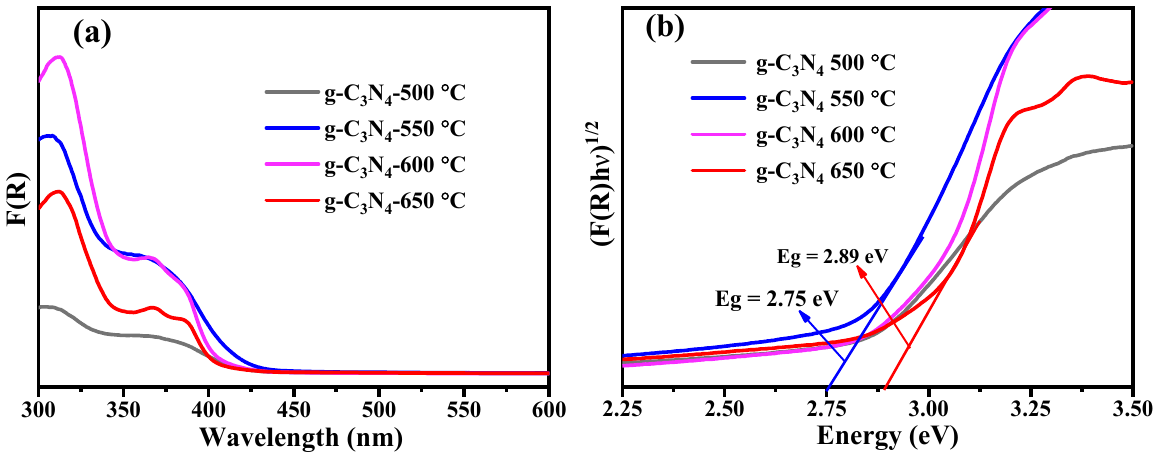
Figure 3. ( a ) UV-Vis DRS spectra and ( b ) corresponding Kubelka–Munk function plot of all pre- pared g-C 3 N 4 samples.